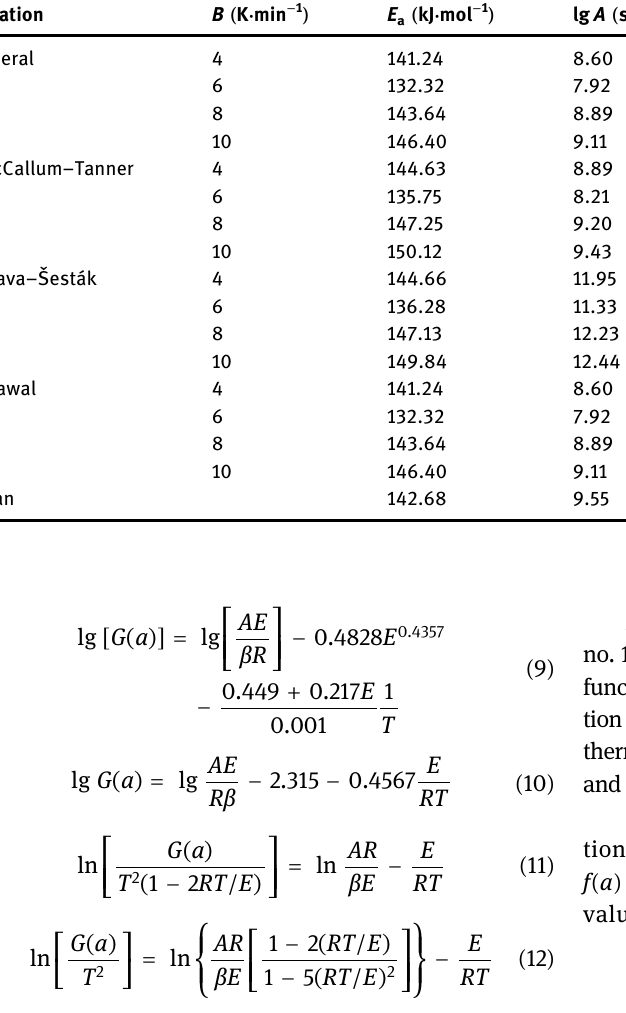
Table 4: Kinetic parameters of main stage of polyacrylate PSA thermal decomposition Equation